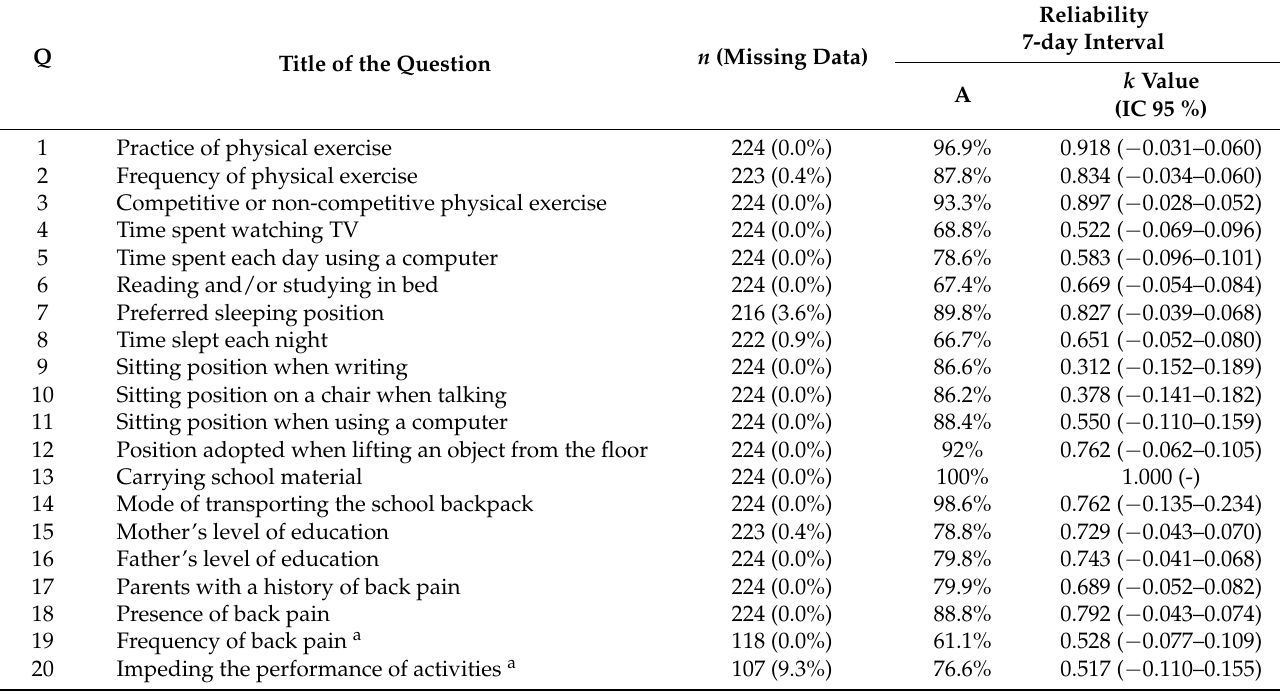
Table 4. Results of the Cohen’s kappa coefficient for the 20 questions in the Spanish version of BackPEI. Reliability tested by applying the questionnaire at two different times with a week